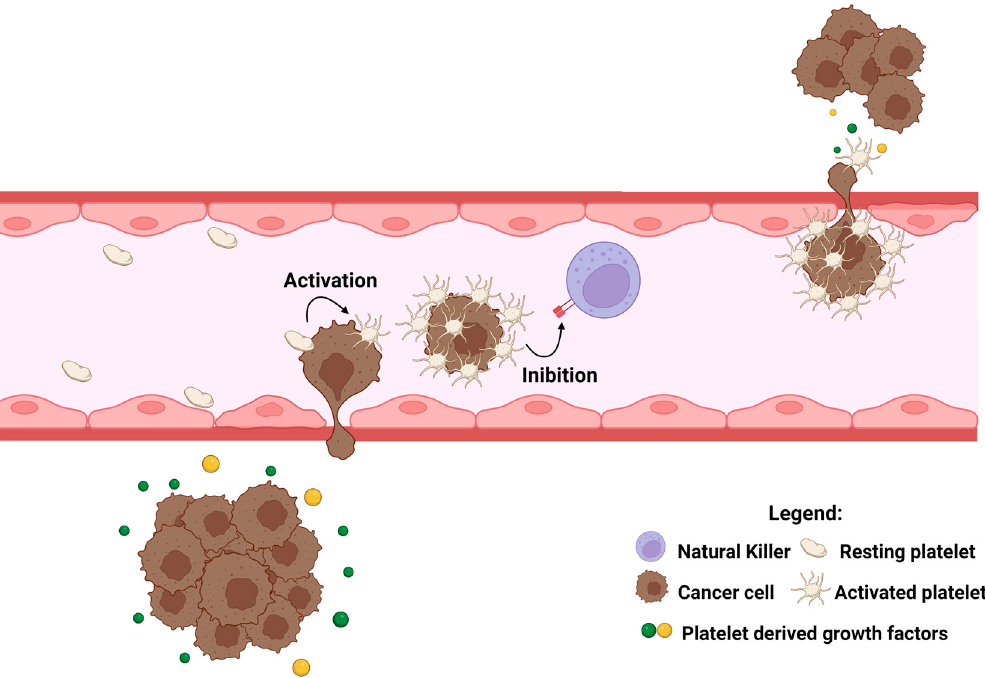
Figure 3. Cancer-platelet interplay. The cancer-platelet interaction is bidirectional. Cancer cells express several molecules able to interact with platelet receptors capable of forming aggregates of platelets and cancer cells, which leads to platelet activation and creation of a pro-thrombotic environment on one side, and to tumor cell extravasation on the other. In turn, platelet activation by cancer cells promotes the release of the platelet secretome, including proinflammatory cytokines and growth factors that promote tumor growth, modulate the tumor microenvironment by recruiting and activating leukocytes, and favor the formation of metastases. Furthermore, platelet-derived TGF- β decreases the NK cell patrolling activity, thus increasing tumor cell survival. Created in BioRender.com (accessed on 29 December 2022) .